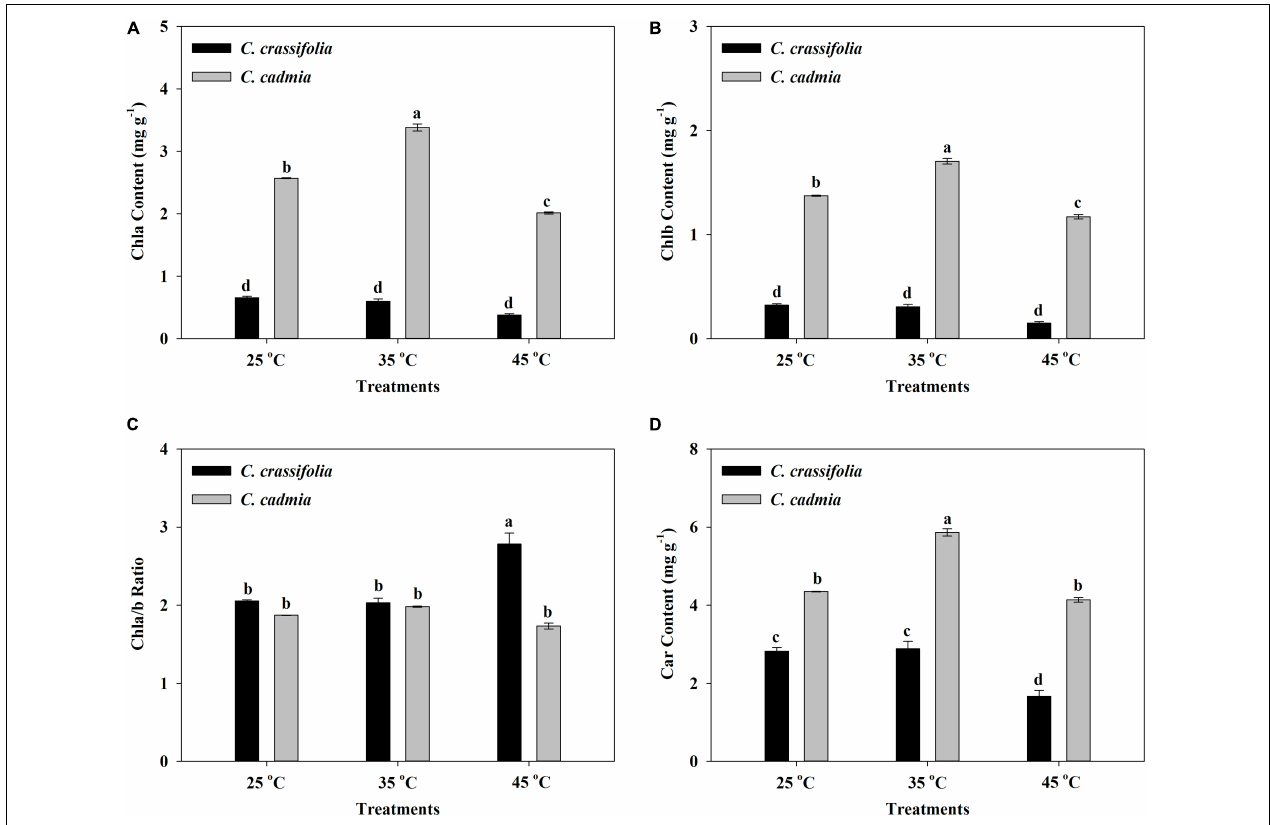
FIGURE 2 | Chlorophyll a (Chla), chlorophyll b (Chlb), chlorophyll a/b ratio, and carotenoid (Car) in C. crassifolia and C. cadmia grown under three different temperatures including normal temperature (25 ◦ C), moderate temperature (35 ◦ C), and high temperature (45 ◦ C). (A) Chla content. (B) Chlb content. (C) Chla/b ratio. (D) Car content. Error bars indicate SE ( n = 5 plants). Different letters indicate significant differences based on two-way ANOVA followed by Tukey multiple comparisons ( P ≤